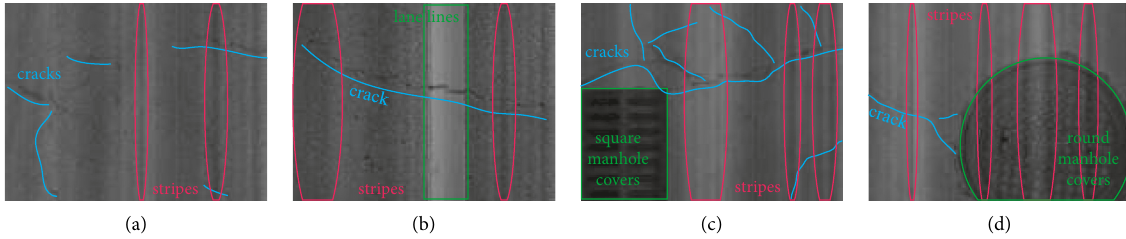
Figure 1: Original line array pavement image with (a) single-content; (b) lane lines; (c) square manhole covers; (d) round manhole covers.